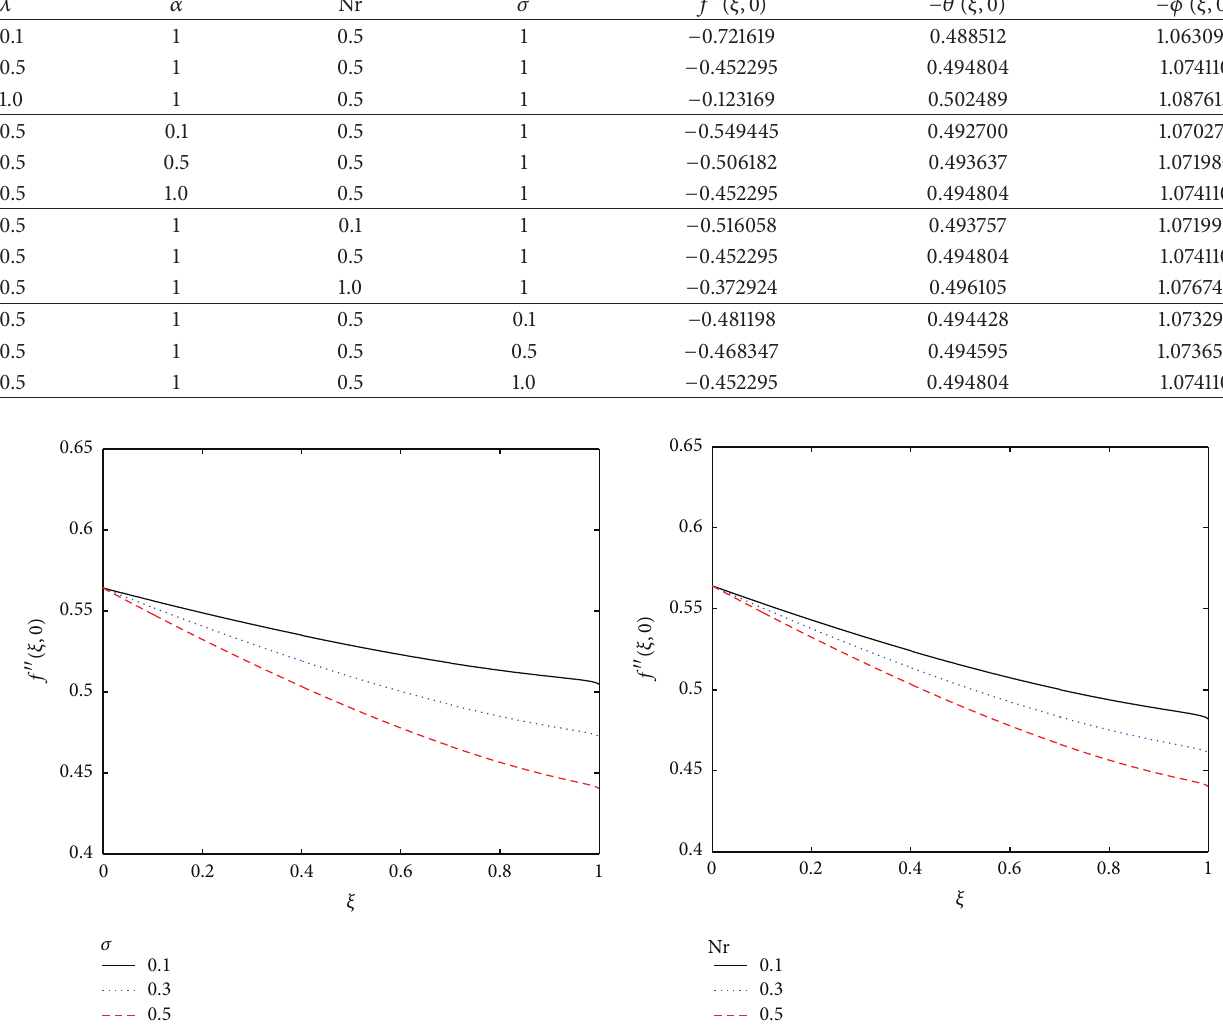
Figure 2: Effect of 𝜎 and Nr on the skin friction